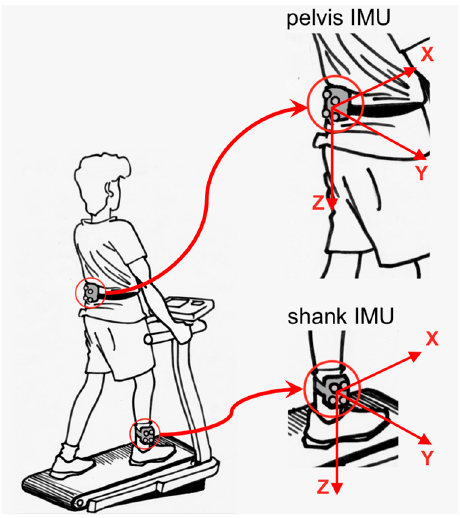
Figure 1. Unit Local Frames for the shank and pelvis Inertial Measurement Units (IMUs).